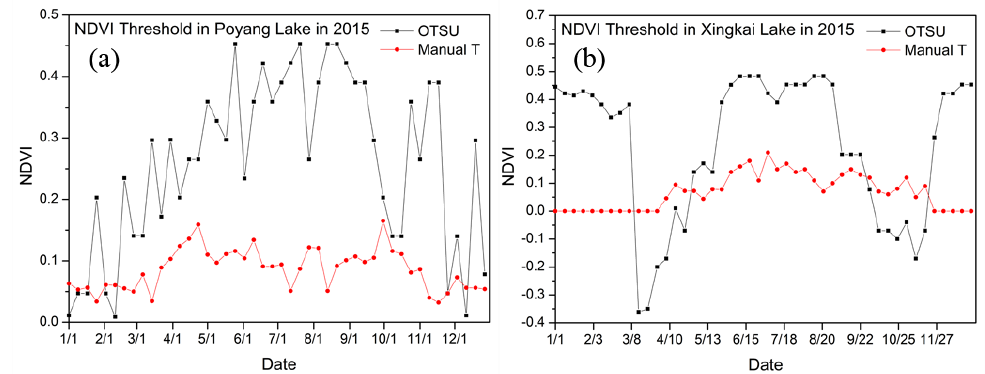
Figure 14. Comparison of water normalized difference vegetation index thresholds between the OTSU threshold and manual threshold, taking Poyang Lake ( a ) and Xingkai Lake ( b ) as examples.